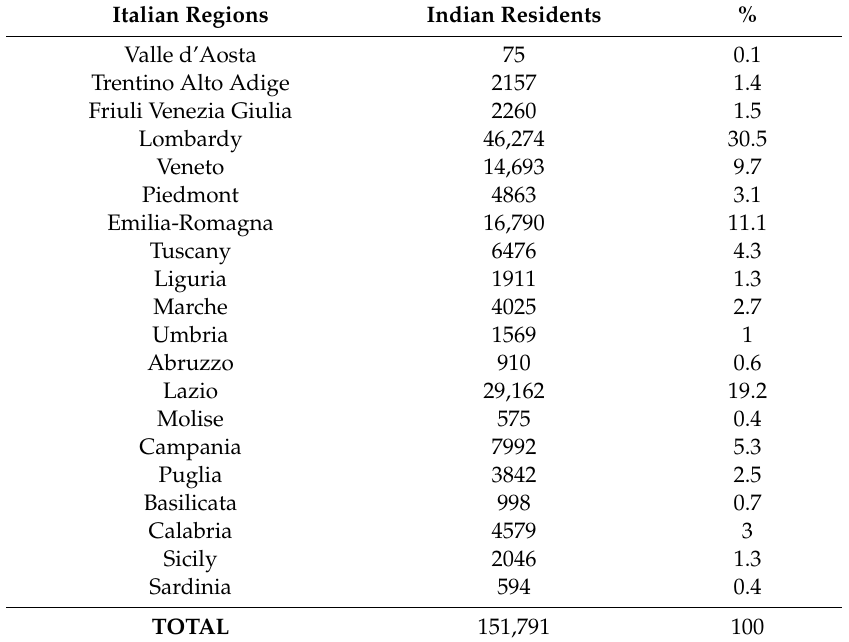
Table 1. Indian residents in the various Italian regions and percentage distribution at 31 December 2017. 7